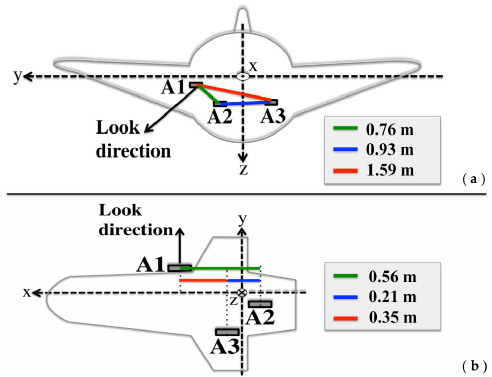
Figure 2. Interferometric layout of the InSAeS4 System. ( a ) Vertical ( i.e. , across track) plane; ( b ) Horizontal plane. Note that the x-axis points ahead and z-axis points downward. Table 4. Baseline vs. Height of ambiguity.